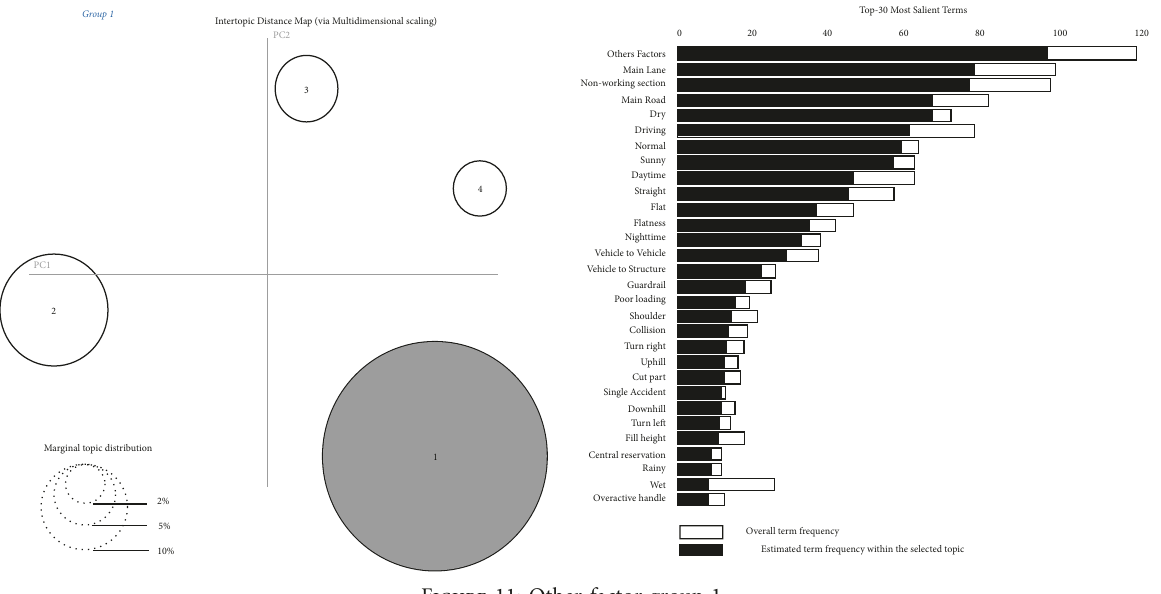
Figure 11: Other factor group